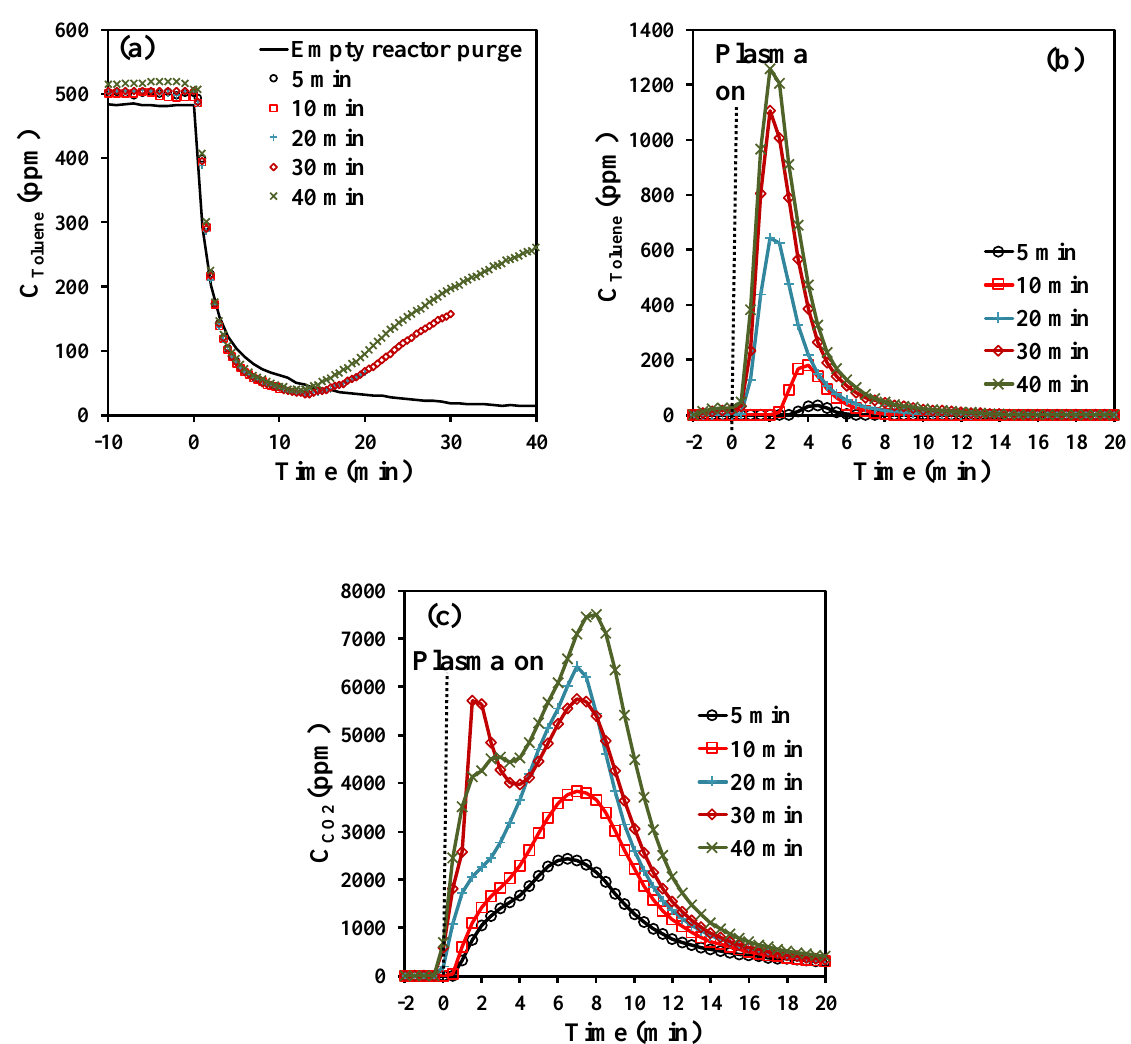
Figure 1. Effect of toluene stage duration time (t 1 ) on the concentration profiles of ( a ) toluene during the adsorption step (including a blank test without catalyst), ( b ) toluene during NTP exposure for the first 20 min (toluene desorption), and ( c ) CO 2 during NTP exposure for the first 20 min (CO 2 formation).